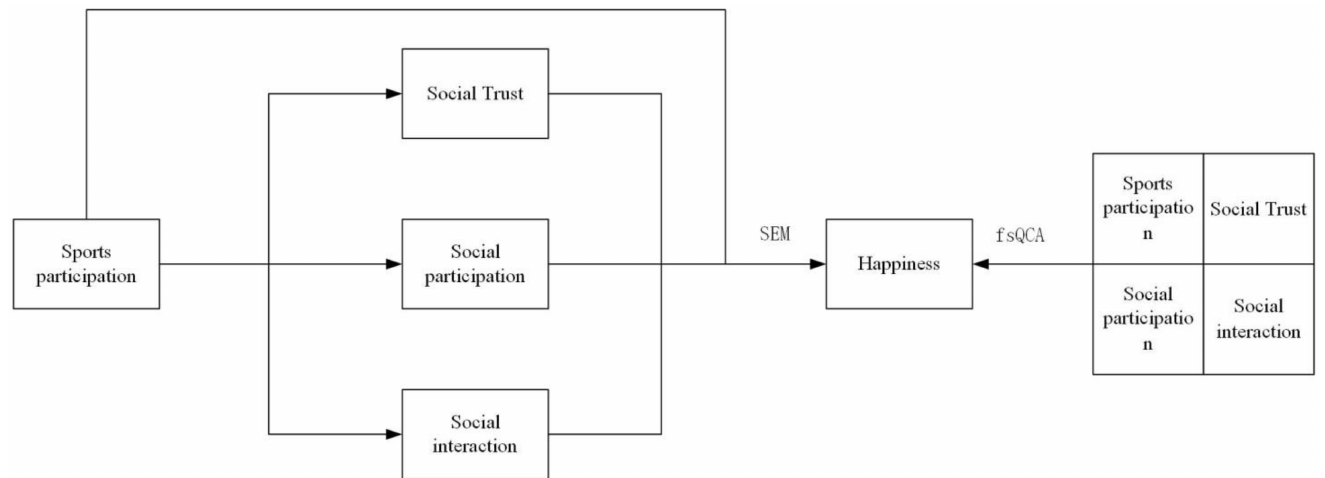
Figure 1. A theoretical model of the influence of sports gateball engagement on elderly people’s